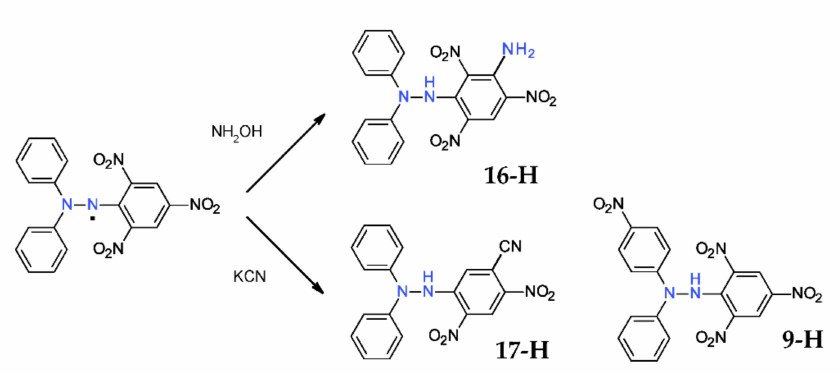
Figure 9. Reaction of DPPH · with hydroxylamine and KCN.